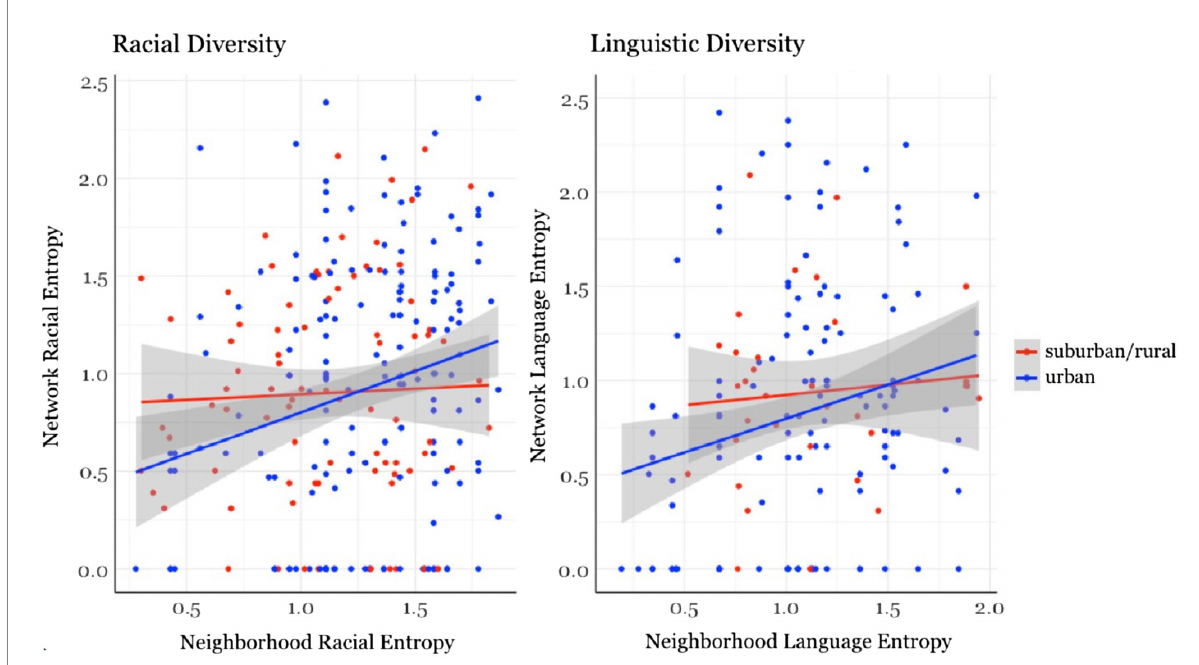
FIGURE 3 For urban subjects only, there was a positive correlation between Network and Neighborhood Racial Diversity ( rho = 0.24, p = 0.002) and Network and Neighborhood Linguistic Diversity ( rho = 0.25, p = 0.004). Shaded area indicates the 95% confidence